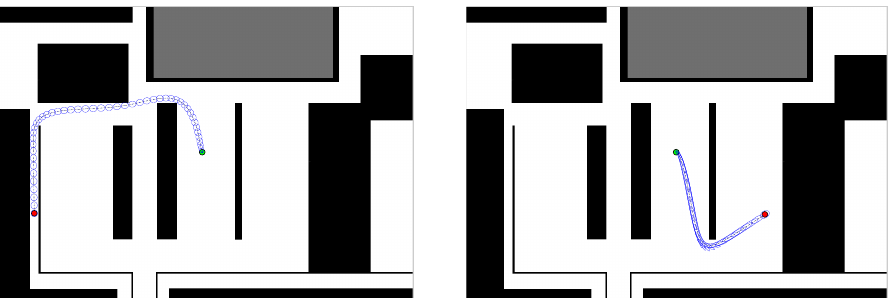
Figure 5. Two examples of optimal paths computed using AICO in a static